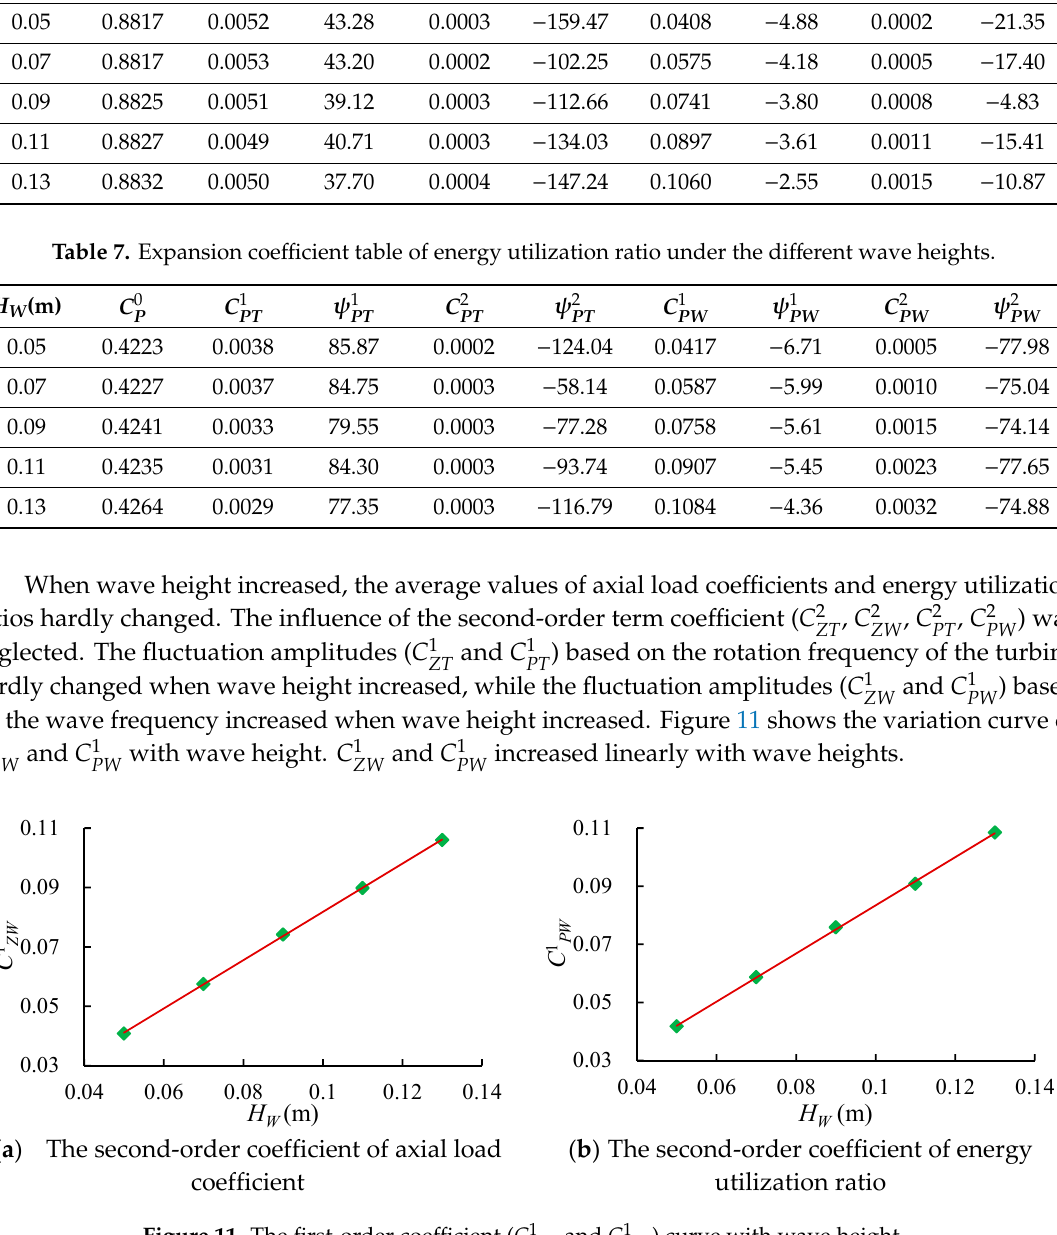
Figure 11. The first-order coefficient ( 1